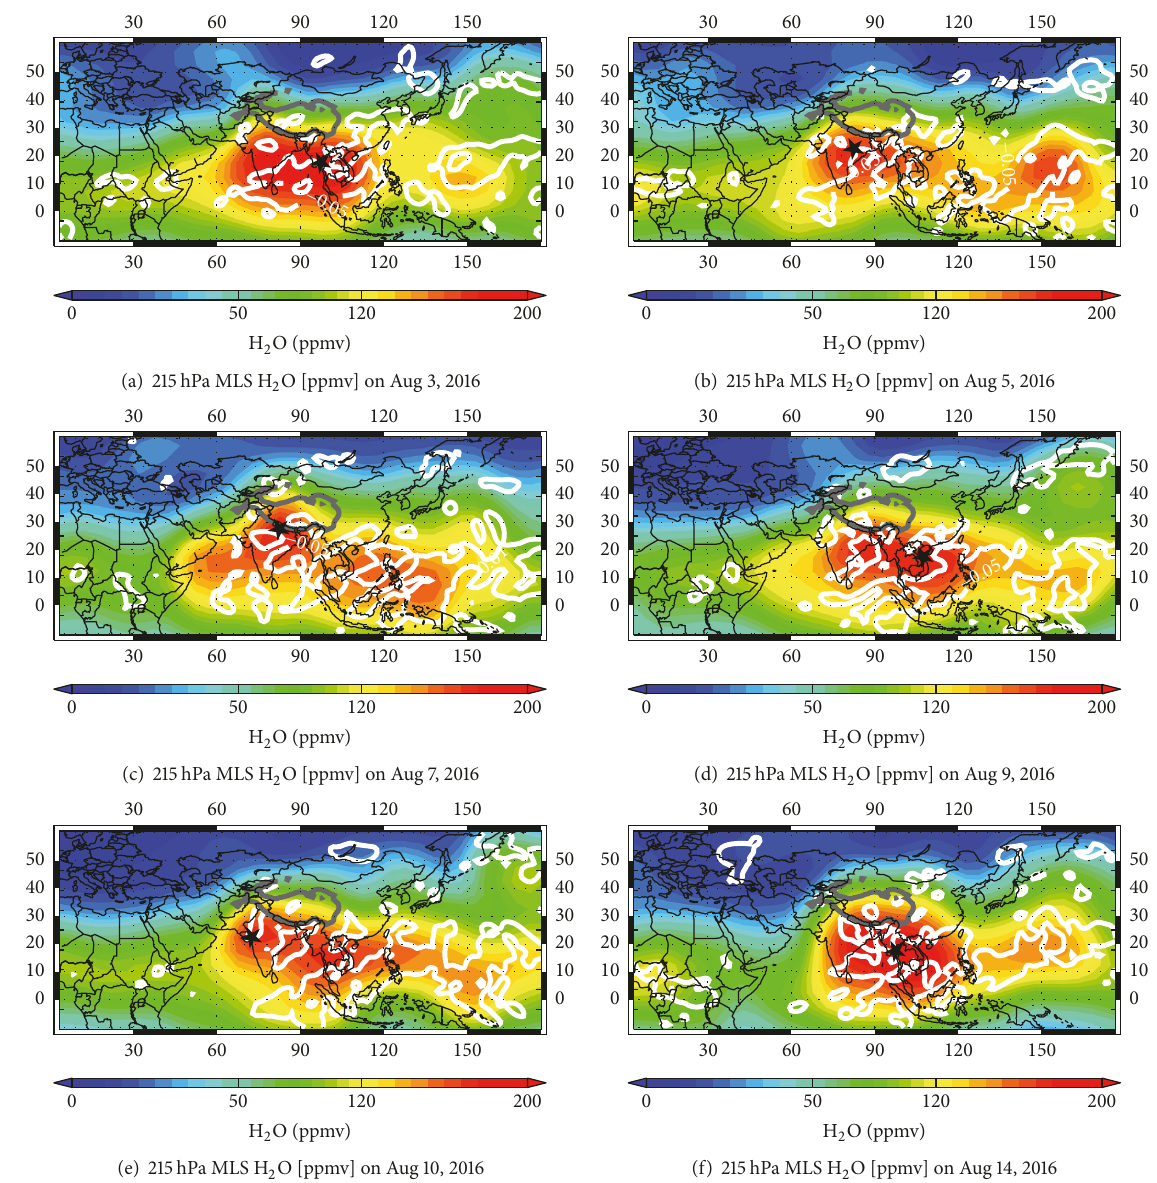
Figure 6: The same as Figure 4, but for MLS H 2 O at 215